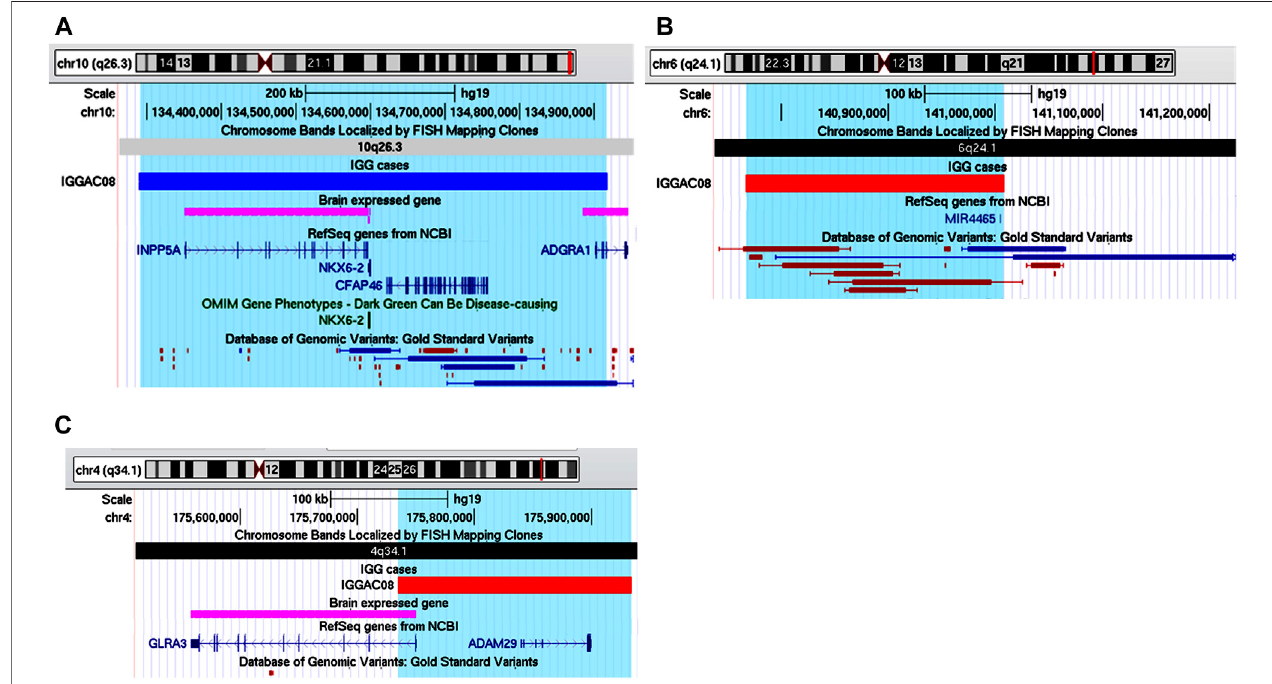
FIGURE5 | Additive effects of INPP5A , MIR4465 and GLRA3 in patient IGGAC08. (A) Screenshot of chromosome 10 region encompassing the duplication of patient IGGAC08 (blue bar, chr10:134,289,353-134,917,702). (B) Screenshot of chromosome 6 region encompassing the deletion of patient IGGAC08 (red bar, chr6:140,767,462-141,008,265). (C) Screenshot of chromosome 4 region encompassing the deletion of patient IGGAC08 (red bar, chr4:175,734,964- 175,934,265).